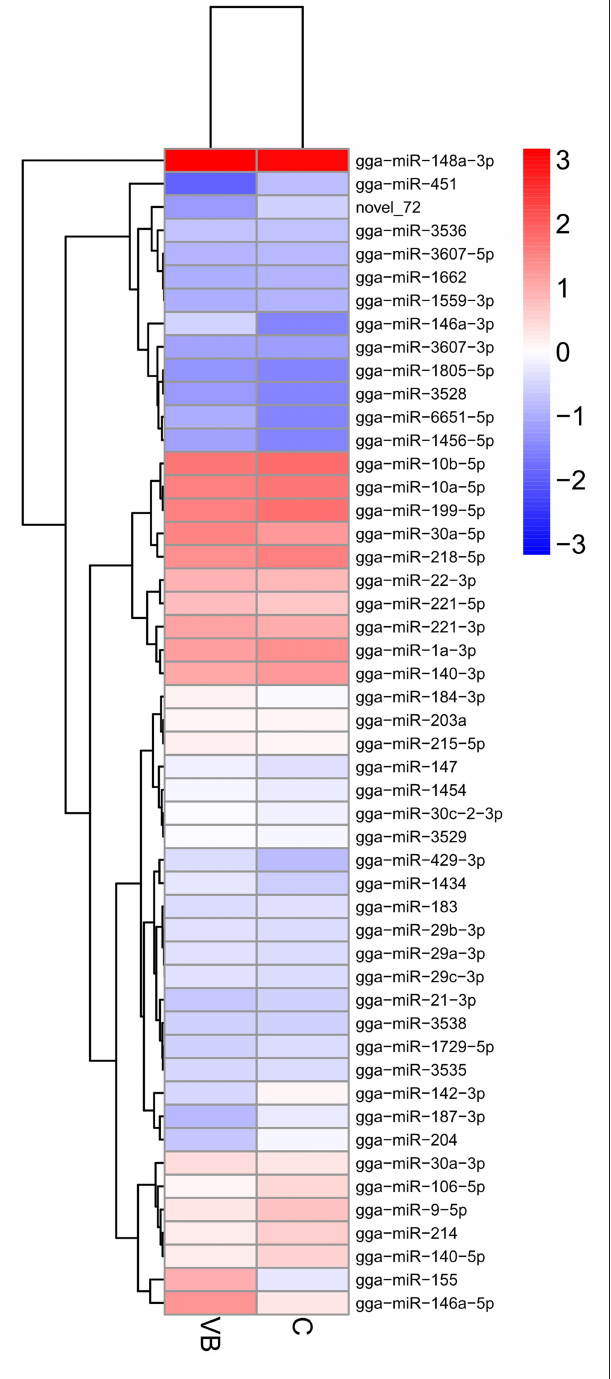
FIGURE 5 | Heatmap of DEmiRNAs across two groups. Expression values of two libraries are presented as fpkm normalized log 10 transformed counts.